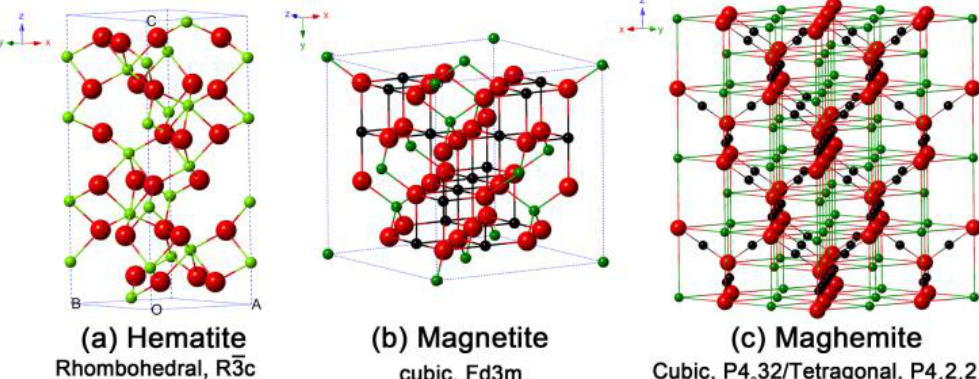
Figure 6. Crystal structure and crystallographic data of the hematite ( a ), magnetite ( b ), and maghemite ( c ) (the black ball is Fe 2 + , the green ball is Fe 3 + , and the red ball is O 2 ). [Reproduced from [38], with permission by license CC BY 3.0, Copyright 2015].